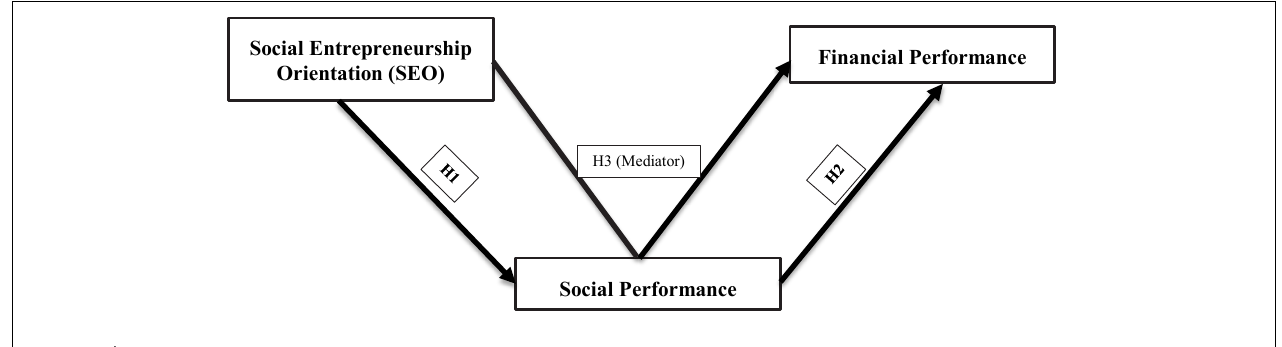
FIGURE 1 | Conceptual model